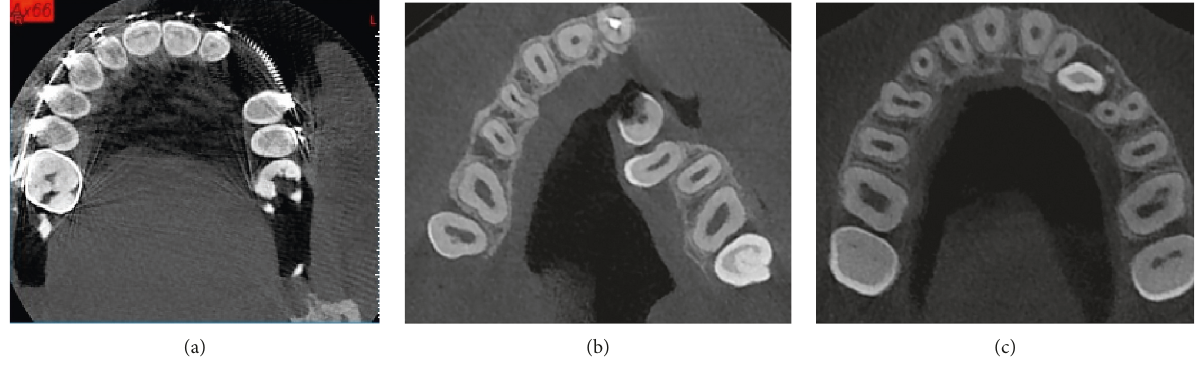
Figure 1: Example of excluded samples. (a) Orthodontic treatment, (b) cleft palate, and (c) impacted